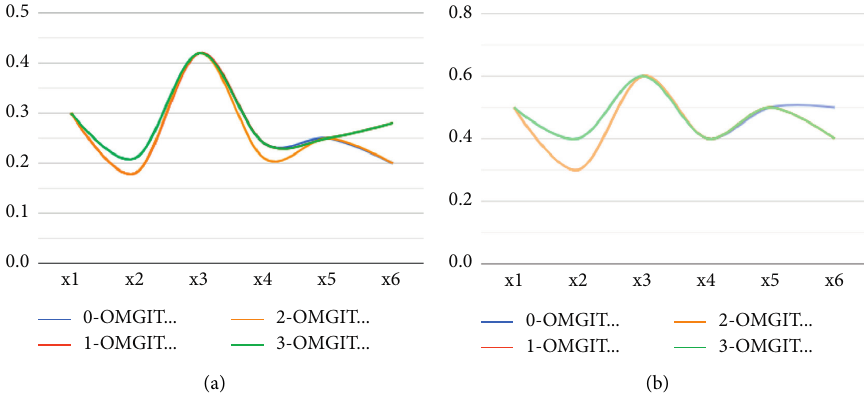
Figure 2: The representations of the upper approximations by using our model and Zhan model in two cases.